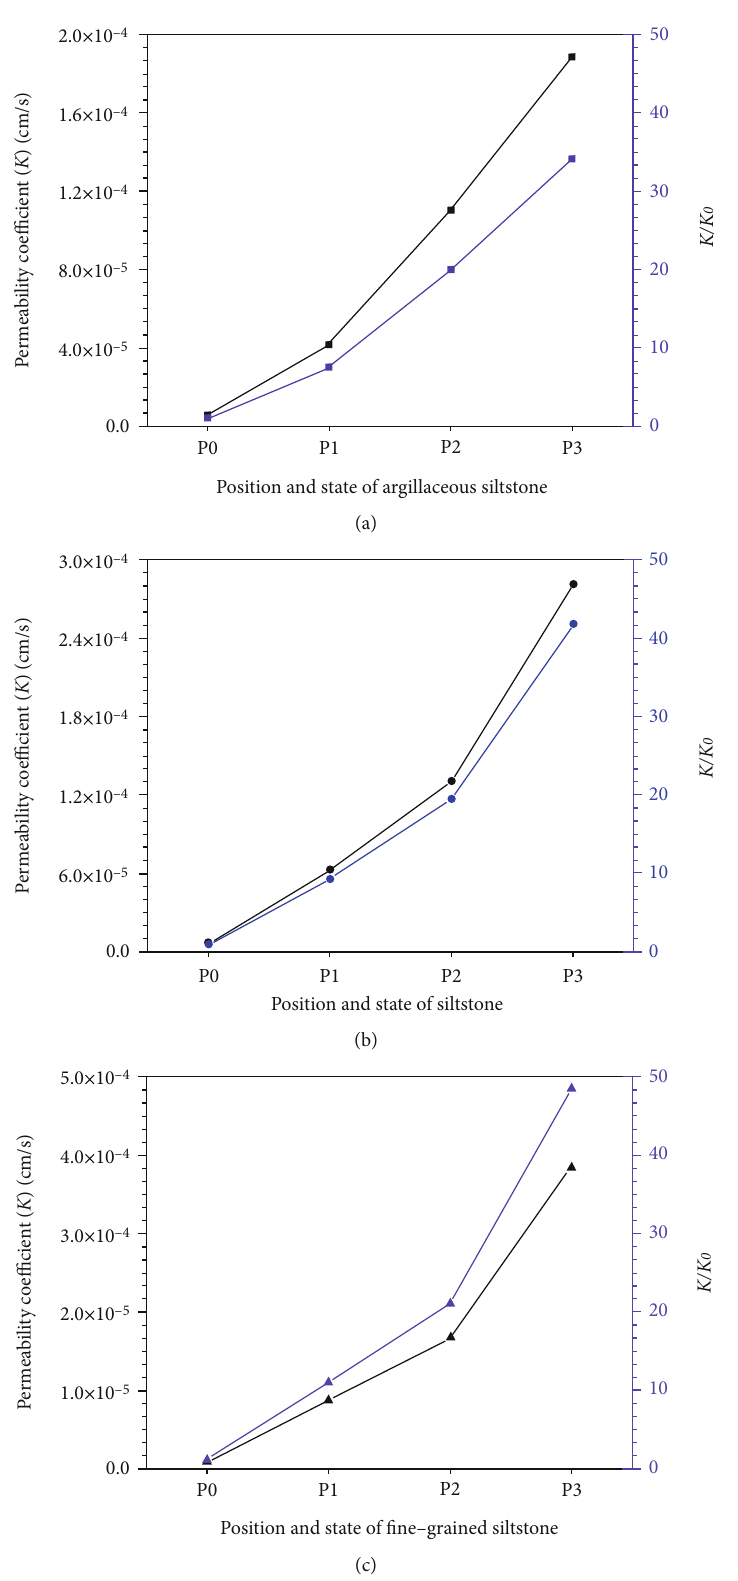
Figure 9: Permeability increase curves of rock with nonpenetrative fracture a ff ected by coal mining: (a) argillaceous sandstone; (b) siltstone; (c) fi ne-grained